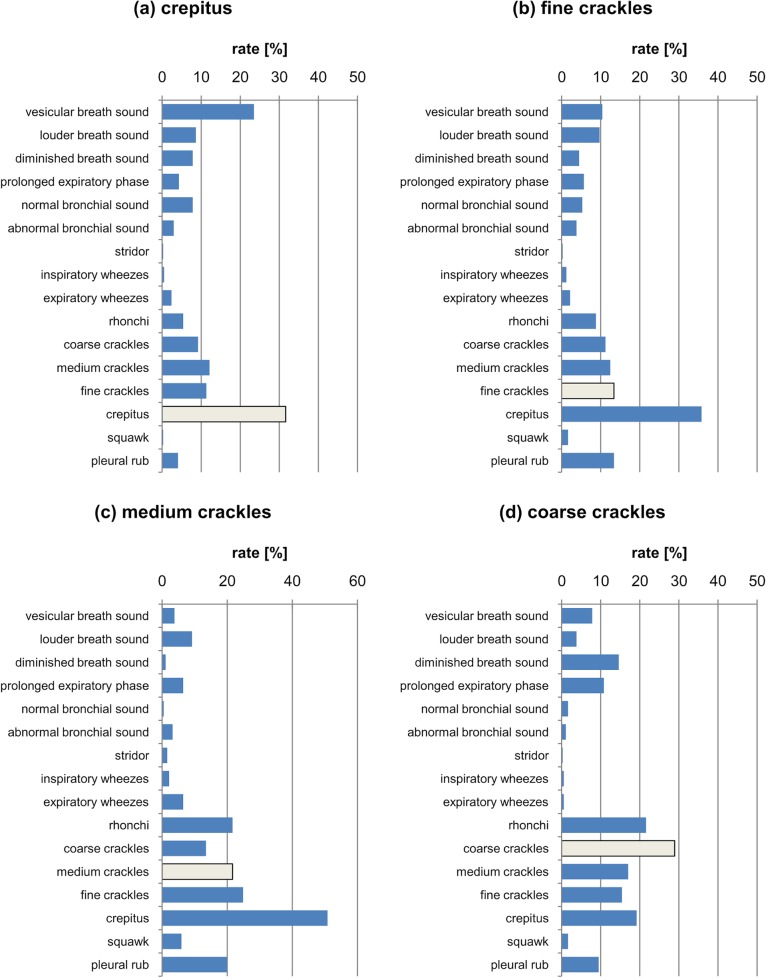
The percentage distribution of responses marked for the classes (a) crepitus (b) fine crackles (c) medium crackles (d) coarse crackles. The light grey bar depicts the correct answer.